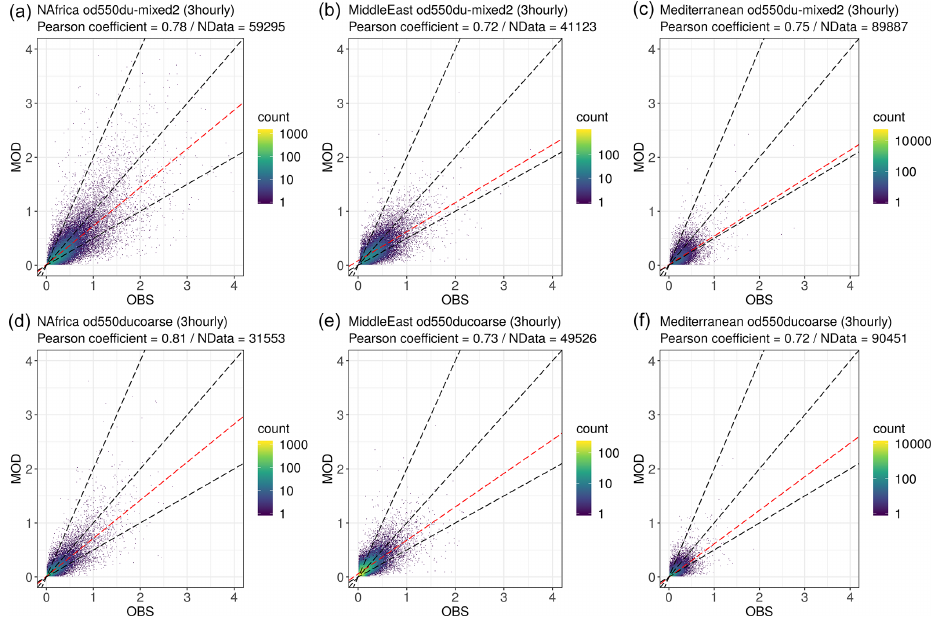
Figure 11. Density scatter plots of the reanalysis (MOD) DOD and DOD coarse versus AERONET (OBS) dust-filtered AOD, DOD- mixed2 (a–c) and DOD coarse (d–f) , during the whole reanalysis period (2007–2016) and on a 3-hourly basis. The results are calculated for three different sub-regions of the reanalysis domain: northwestern Africa (a,d) , the Middle East (b,e) and the Mediterranean (c,f) . The dust filters applied to the AERONET observations are described in Table 6. The bin size is 0.01.